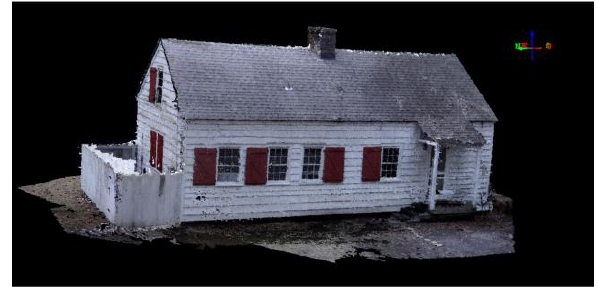
Figure 4. Point cloud of the dock at Wormsloe.